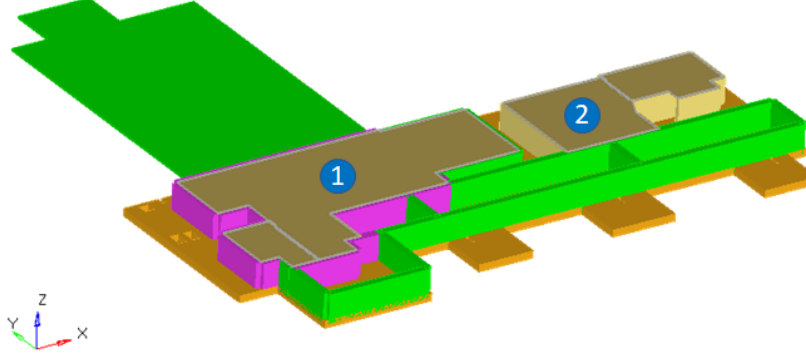
Figure 13. The points 1 and 2 where the transmissibility was determined.